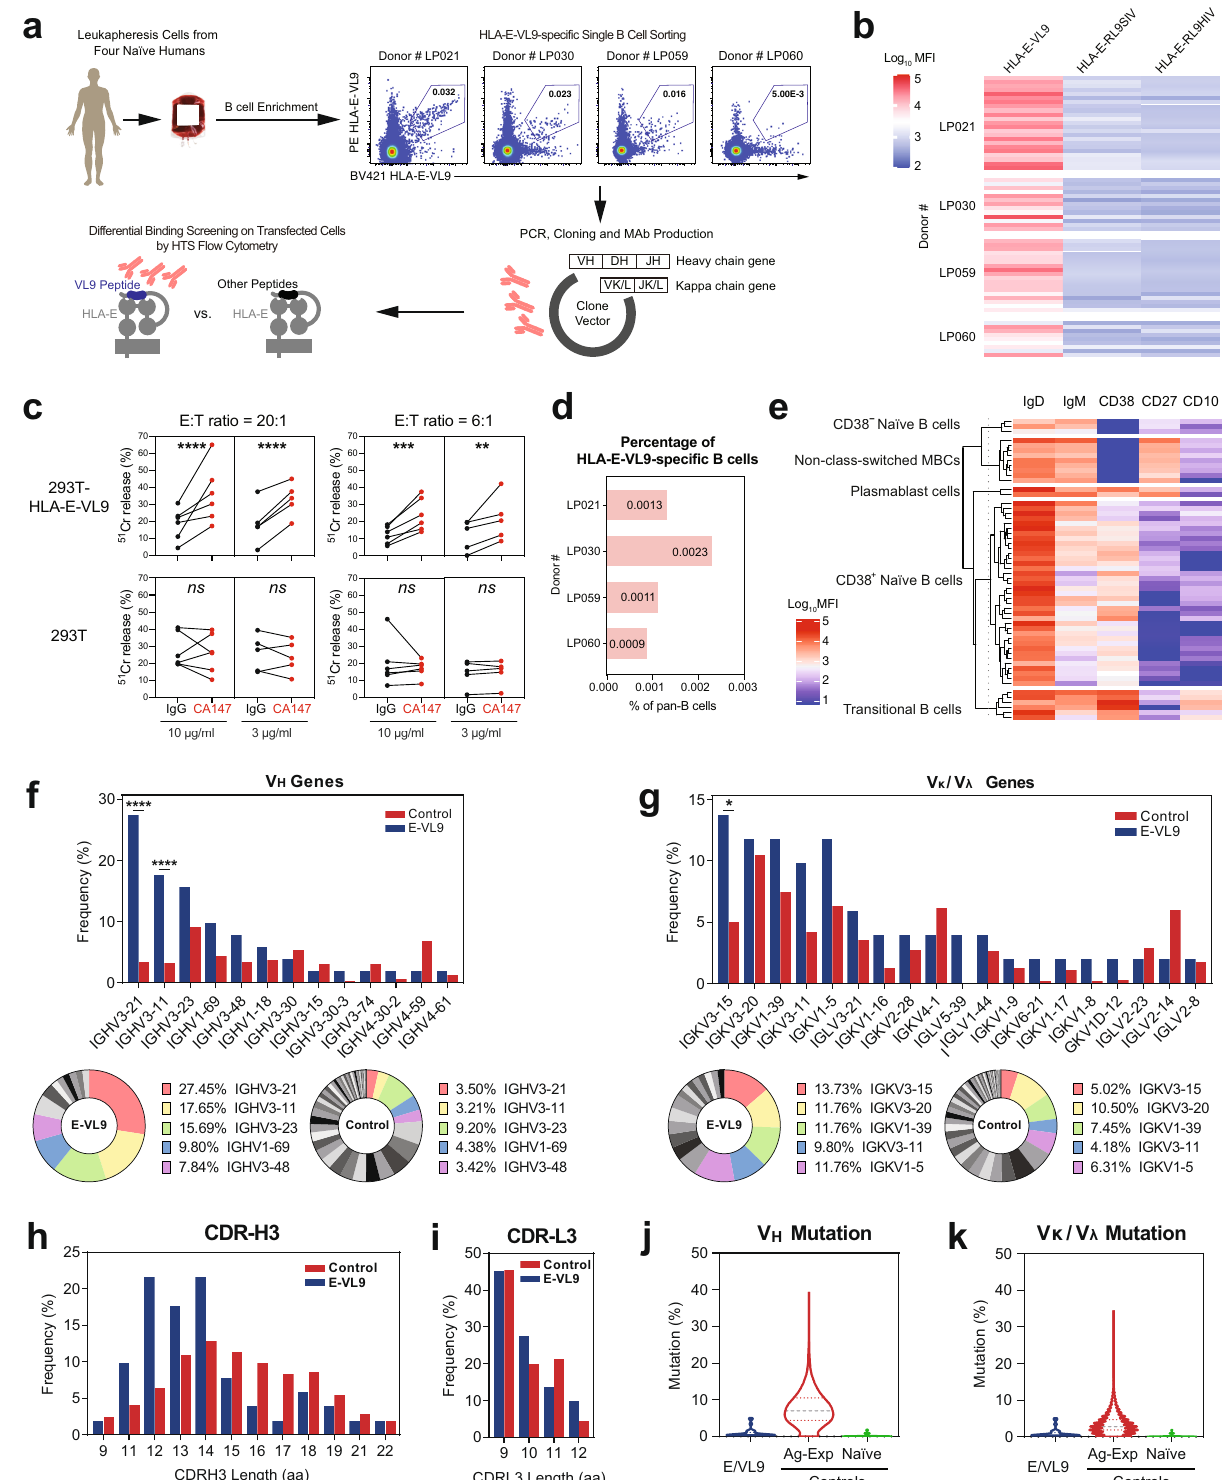
transfected 293T cells (2x10 6 cells/animal) or HLA-E-RL9SIV SCT transfected 293T cells (2 x10 6 cells/animal) at weeks 0, 2, 4, 6, 17 and 19. MAb 13F11 was isolated from this study. In the third experiment, HLA-B27/ β 2m transgenic mice ( n = 10) were i.m. immunized with HLA-E-VL9 complex (25 μ g/animal) adju-